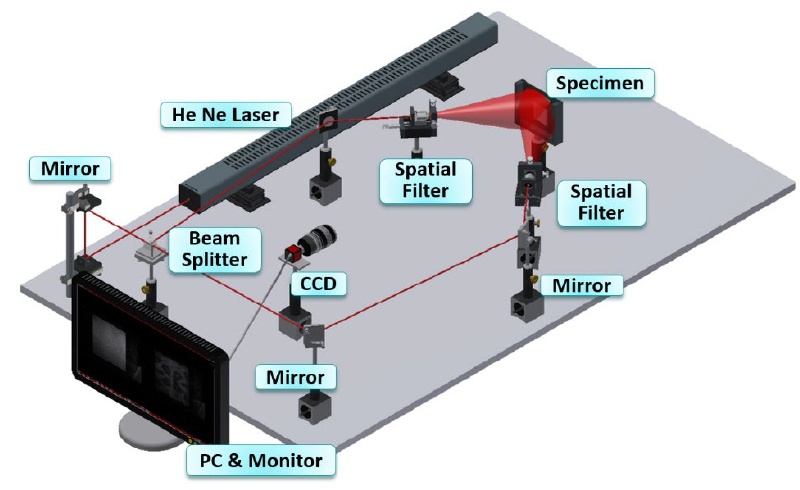
Figure 3. In-plane setup in electronic speckle pattern interferometry (ESPI).